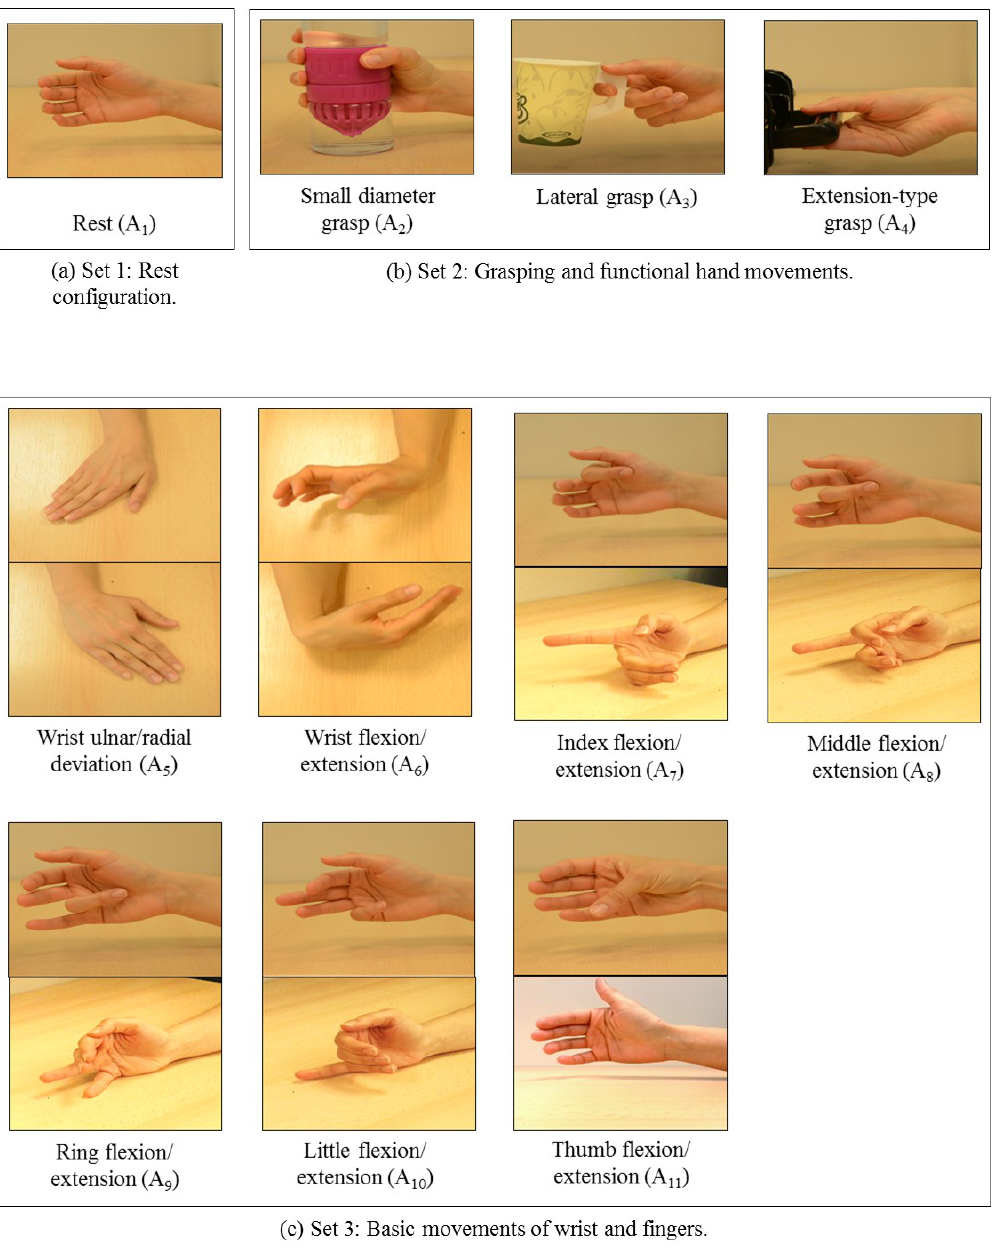
Figure 1. Sample images of the visual cues associated with the different HMITs investigated in this